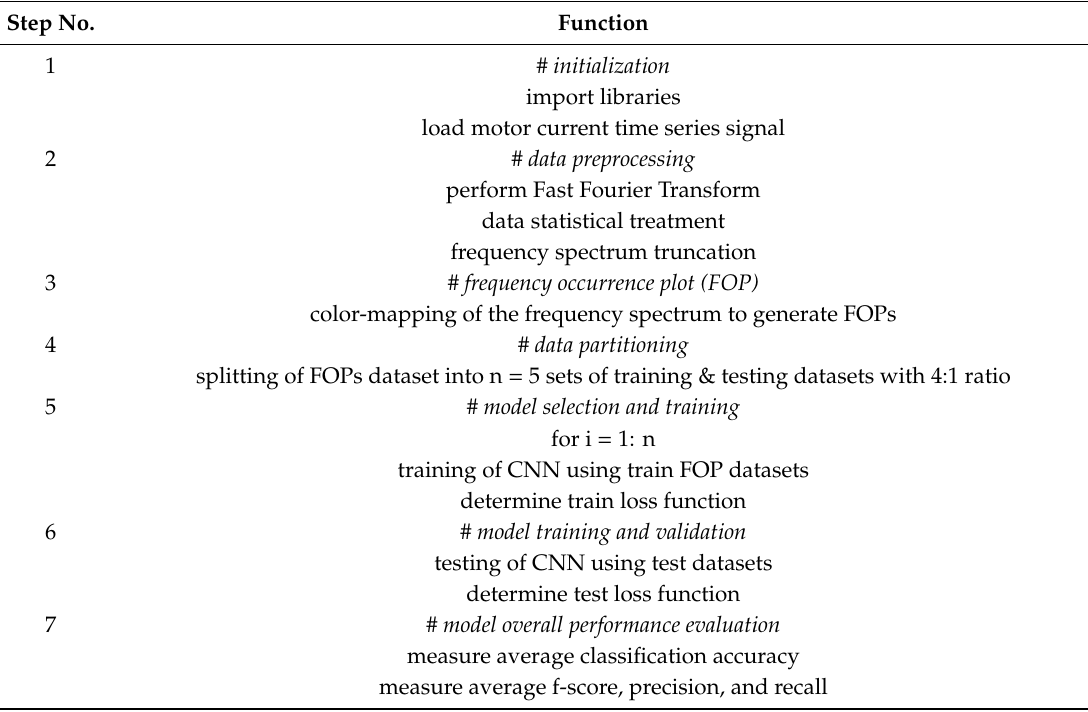
Algorithm 1. Frequency occurrence plot-based (FOP)-CNN pseudocode implemented in Python programming